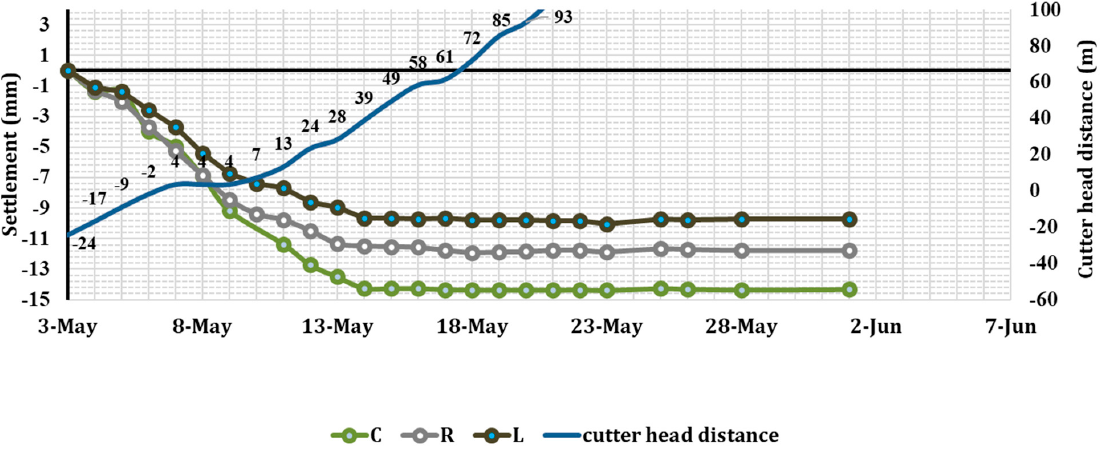
Figure 3. The observed settlements of different points at a section of 2278 m during 30 consecutive days (L, left; C, centered; R, right monitoring points in the transverse section).